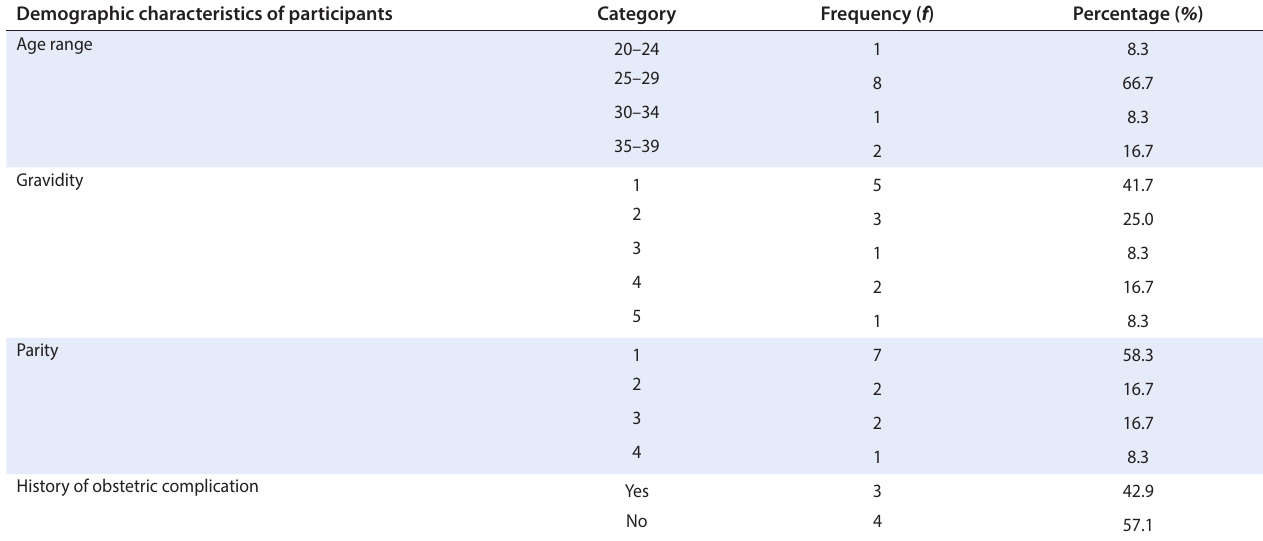
Table 1: Demographic profile of participants ( n = 12)